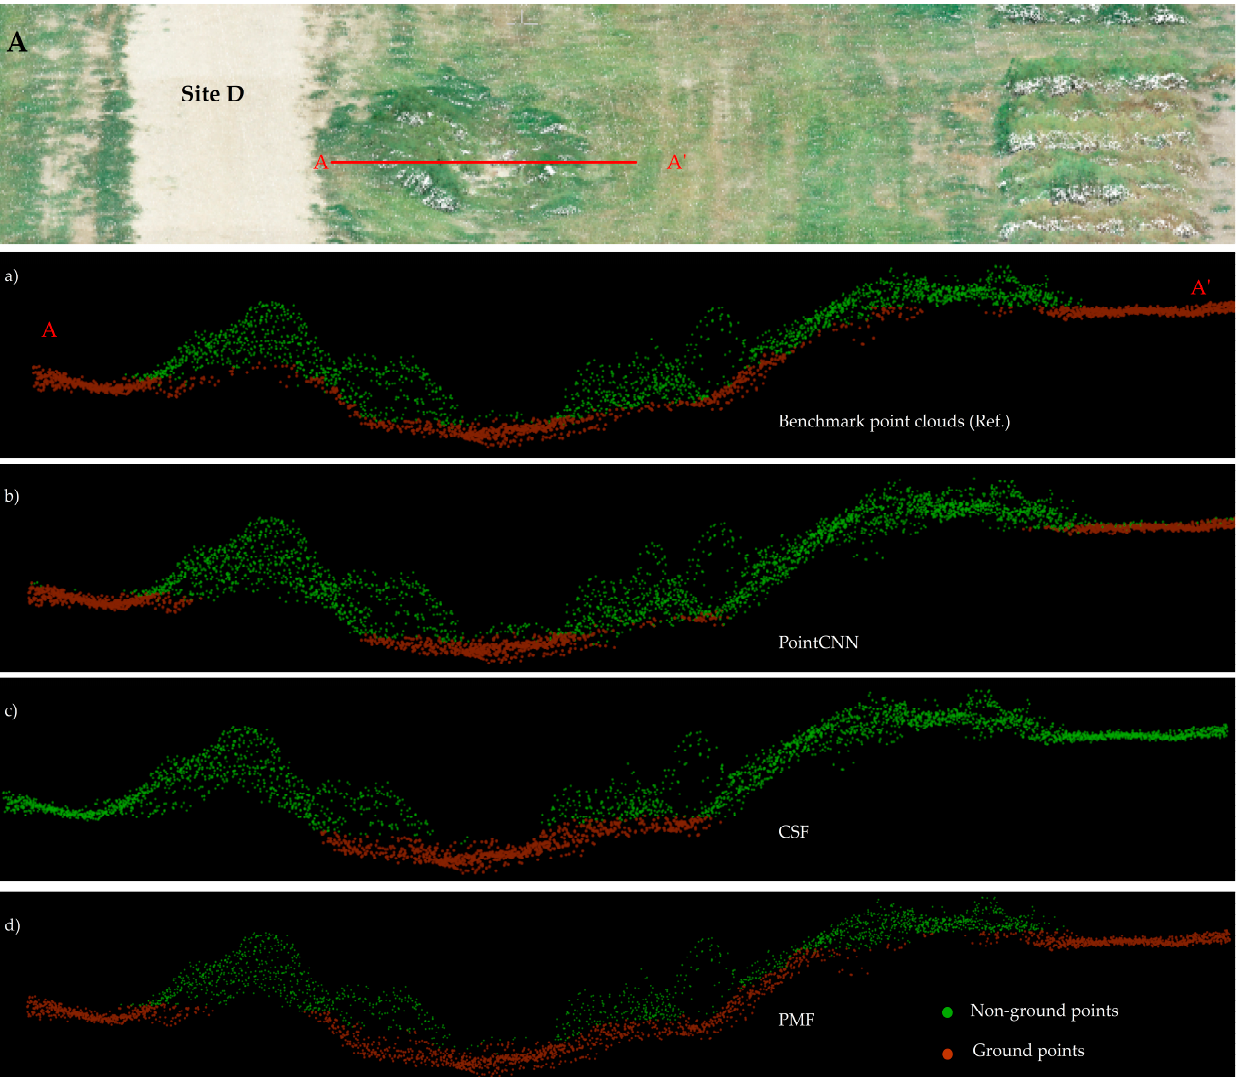
Figure 14. ( A ) Colored DJI L1 point clouds (Site D) with 3D transects (AA’) of ground and non ‐ ground points: ( a ) 3D transects representative of a ditch with benchmark point clouds. ( b ) ground and non ‐ ground points filtered by ( b ) PointCNN, ( c ) CSF, and ( d ) PMF. AA’ transects ( a – d ) are of the same extent (horizontal) for visualization purposes with no vertical scale.